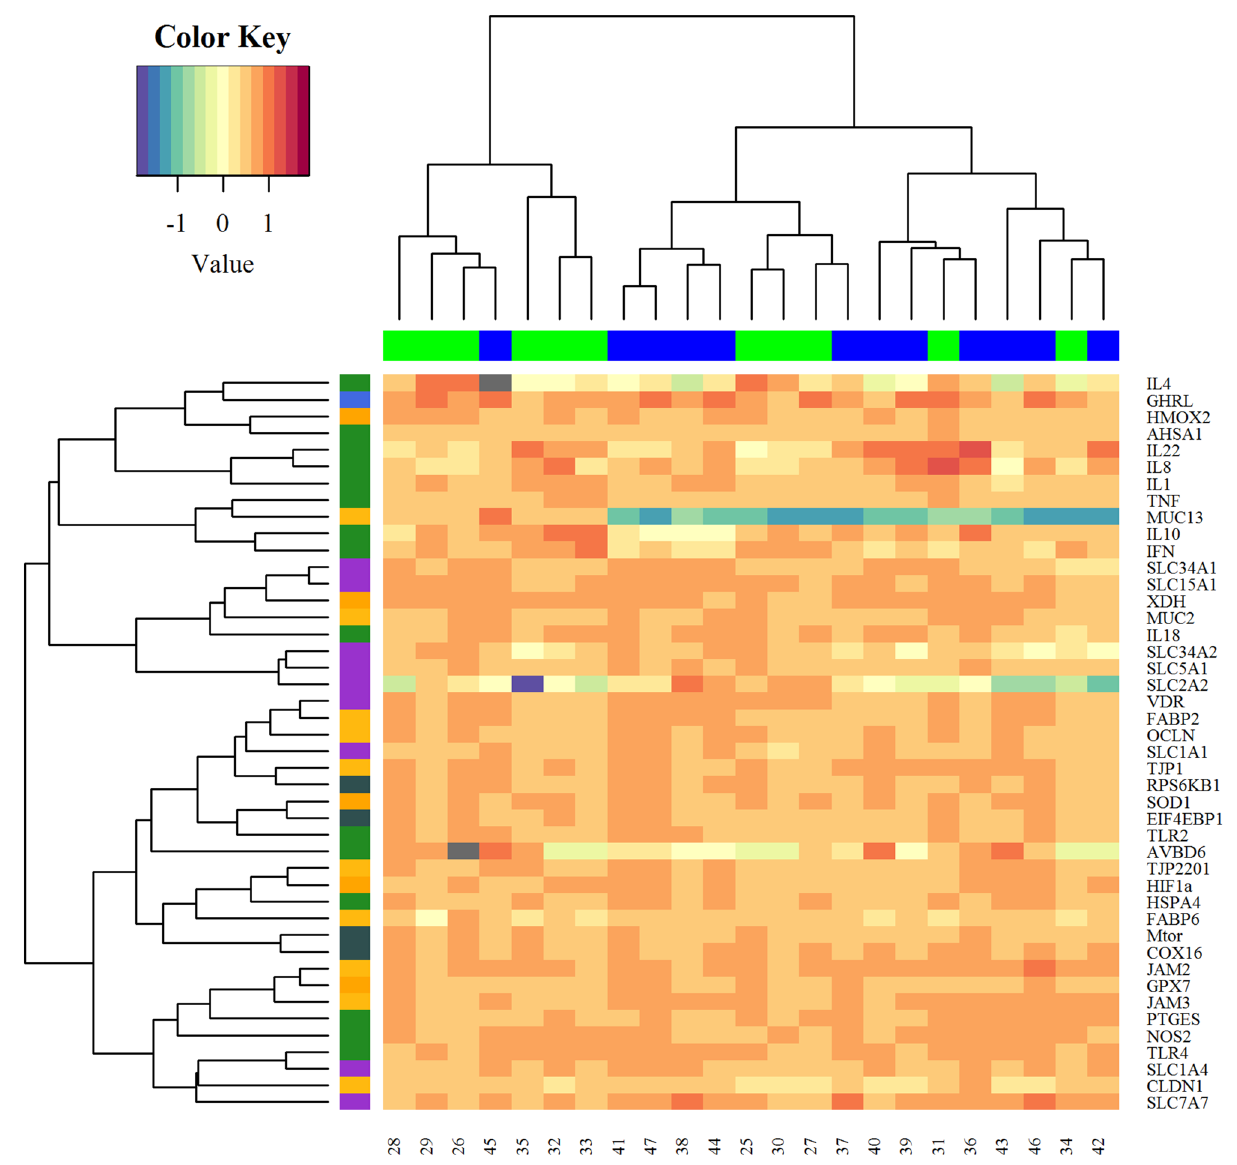
Figure 6. Heat map. The X-axis is sample expression pattern in different treatment group (green colour: negative control; blue colour: negative control + coccidiostat). The Y-axis is the gene clusters according to functions.